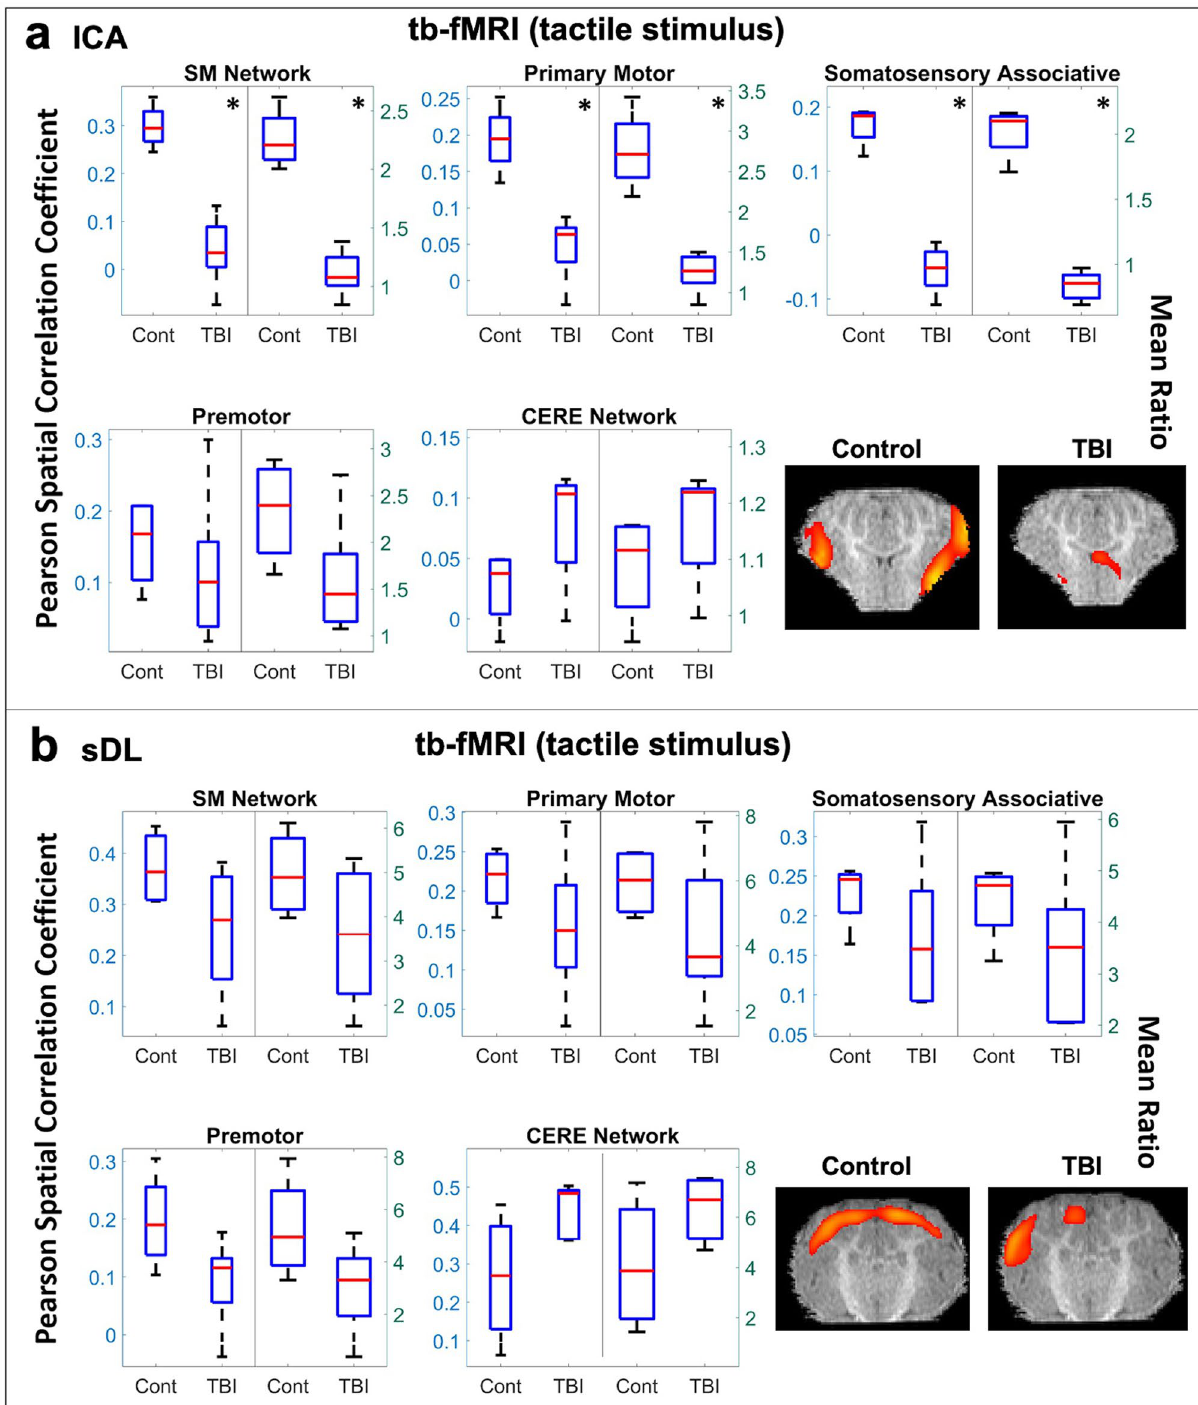
Figure 5. Task-based (tb-) tactile stimulus analysis of the sensorimotor (SM) and cerebellar (CERE) networks. Boxplots of Pearson spatial correlation coefficients (left) and mean ratios (right) obtained from the tb- analysis for the SM network and its individual anatomical regions, as well as the CERE network, obtained using independent component analysis (ICA; a ) and sparse dictionary learning (sDL; b ). The red line denotes the median, the blue box denotes the interquartile range, and the lower and upper whiskers denote the min and max, respectively. An asterisk (*) or pound (#) in the upper right-hand corner indicates significant decrease or increase (p < 0.05), respectively, for the TBI group in comparison to the control group. Representative coronal plane activation maps overlaid on the template pigs’ T1-weighted anatomical image are also displayed. Representative maps in the axial and sagittal plane are provided in the Figures S4 and